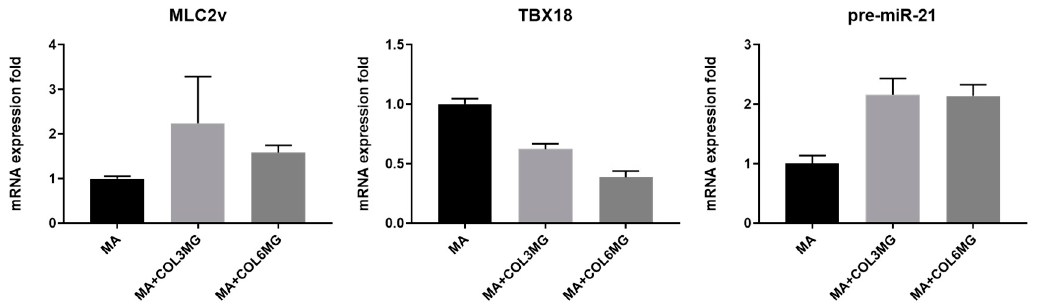
Figure 5. Expression of the cardiomyocyte maturation markers in collagen type I containing hydrogels. Note that the error bars were estimated by the standard deviation of three samples.